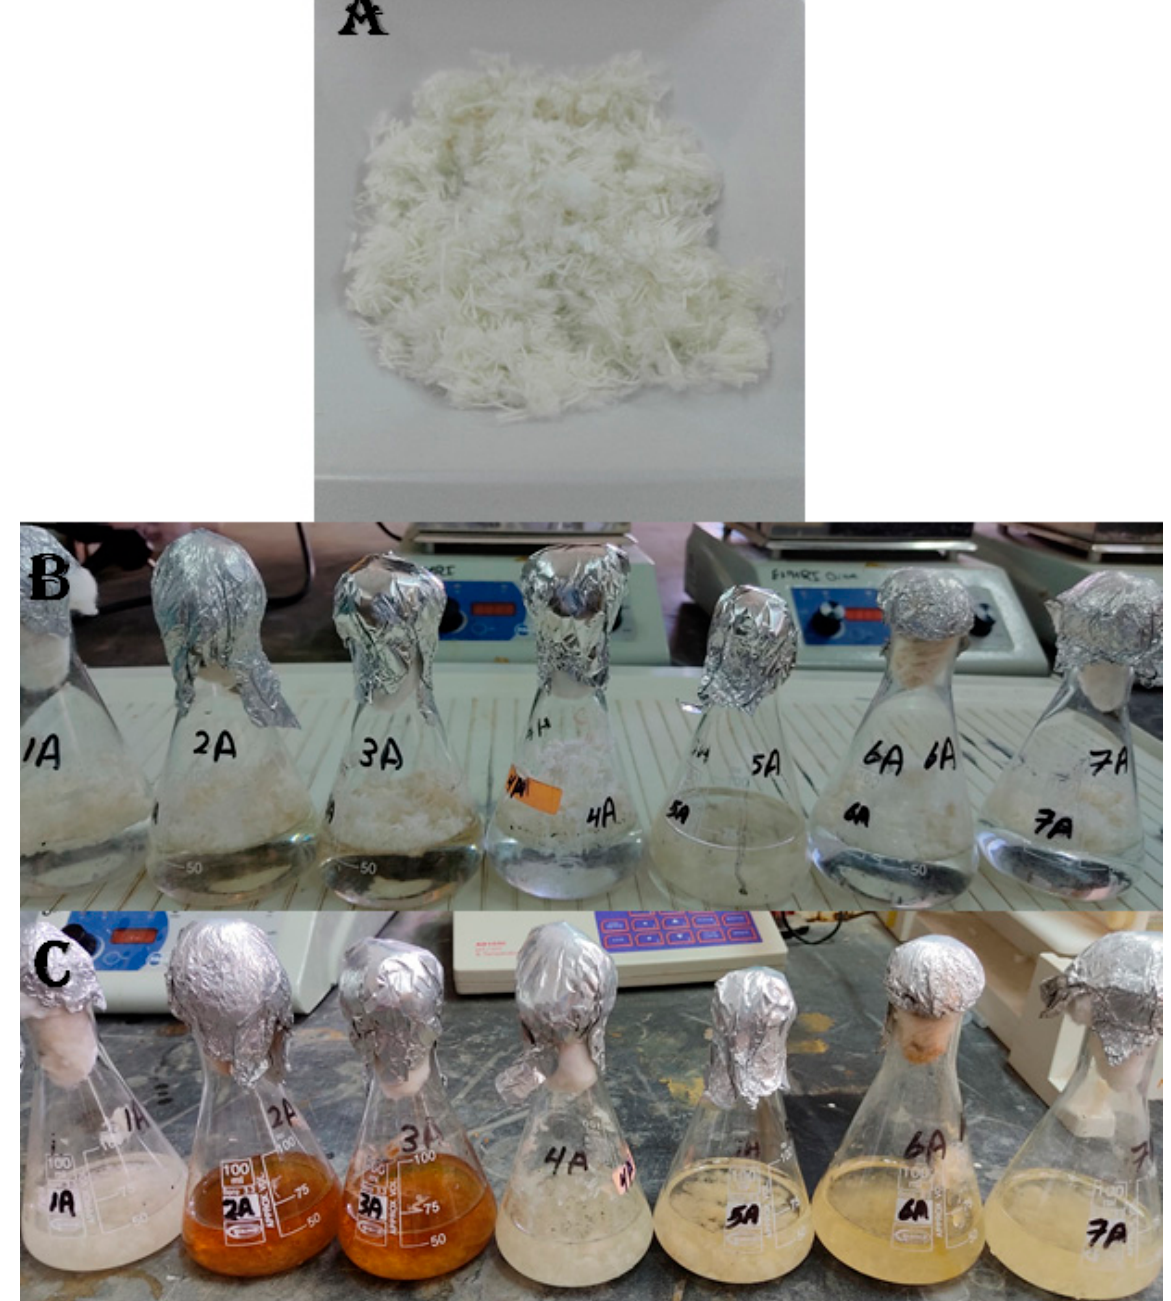
Figure 1. Cellulosic fiber waste ( A ), after chemical treatments ( B ), and after autoclaving ( C